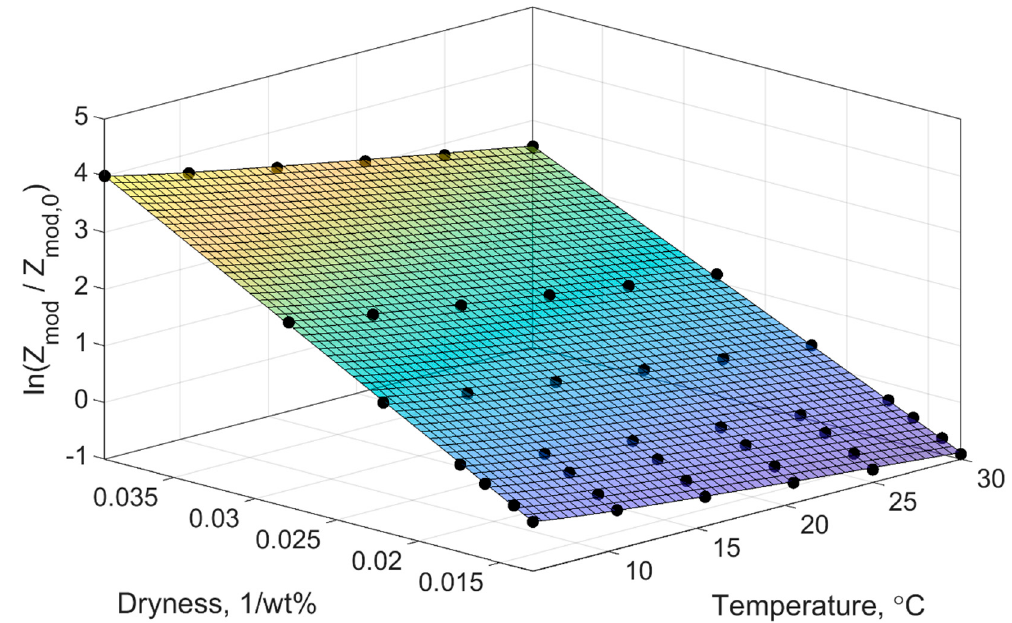
Figure 12. A 3D calibration curve for a fly ash AAM, showing sensor response to both moisture and temperature. Here, dryness is the inverse of moisture content [65].